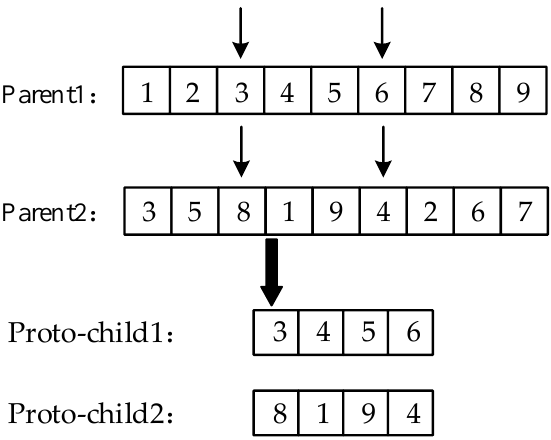
Figure 7. The process of extracting proto-child by Order Crossing Operator.